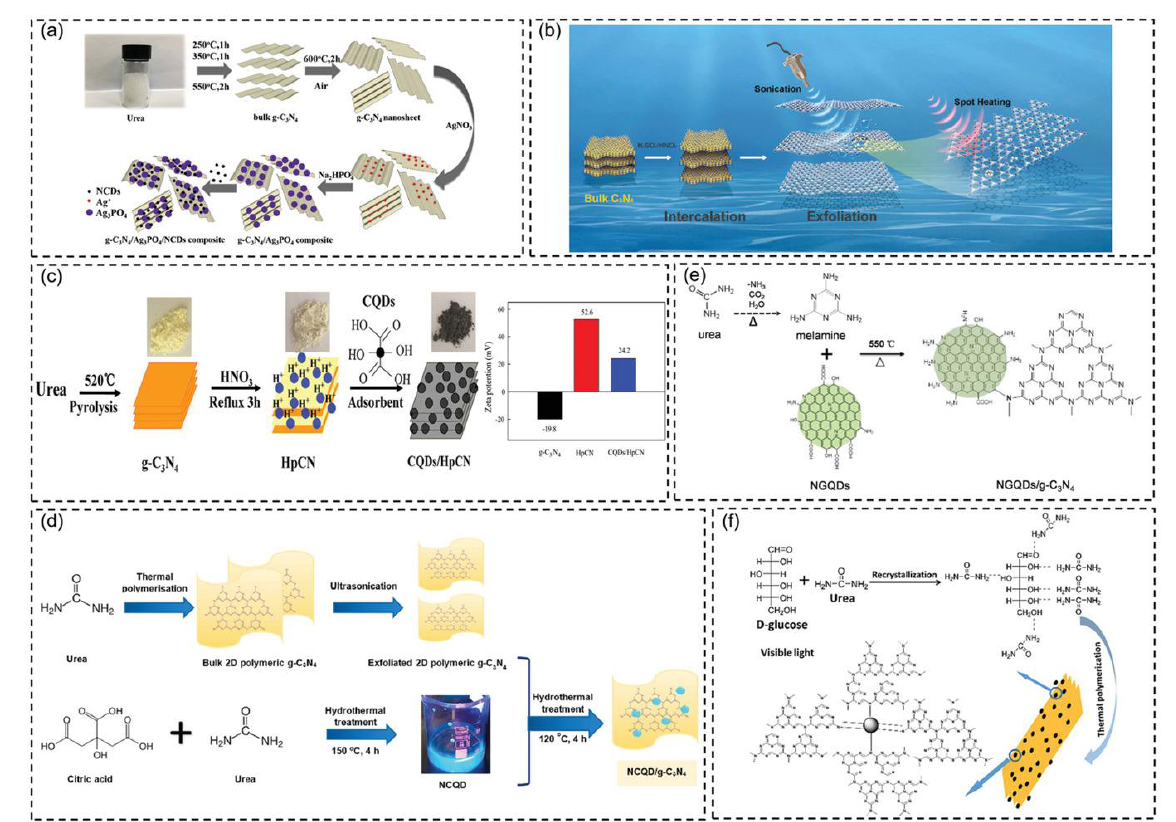
Figure 10. Schematic illustration of the preparation process for g-C 3 N 4 /CD-based nanocomposites through different methods. ( a ) Mechanical mixing method. ( b ) Ultrasonication method. ( c ) Electro- static attraction method. ( d ) Hydrothermal/solvothermal method. ( e , f ) Calcine method. Reprinted with permission from Ref. [130]. Copyright 2021 John Wiley and Sons.